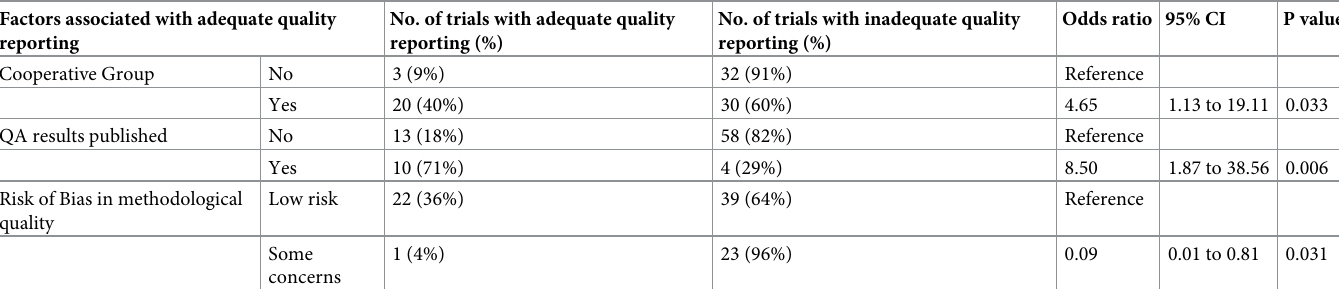
Table 4. Multivariable logistic